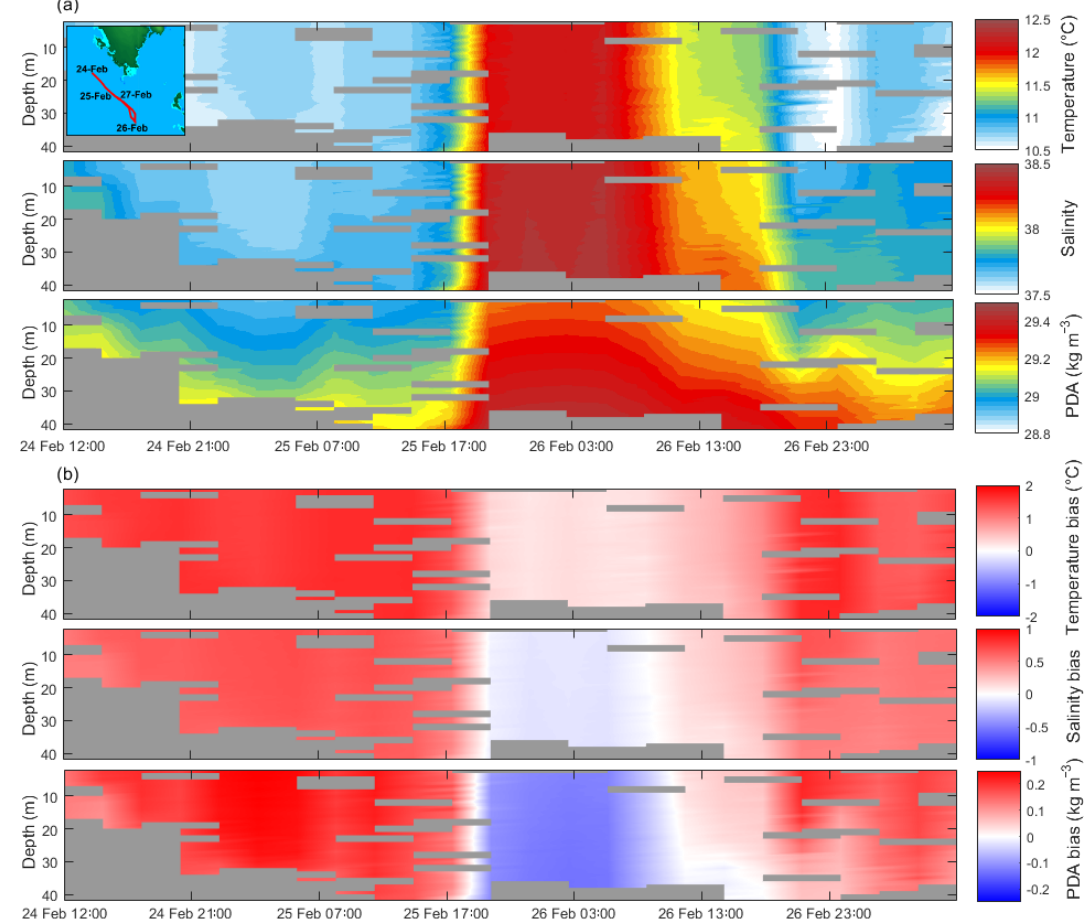
Figure 5. (a) Temperature, salinity and PDA profiles measured by Slocum glider between 24 and 27 February 2015 in front of Kvarner Bay, together with (b) model-to-observation difference (bias). Glider trajectory is plotted in the inset and Fig. 1. Grey blocks denote areas of no